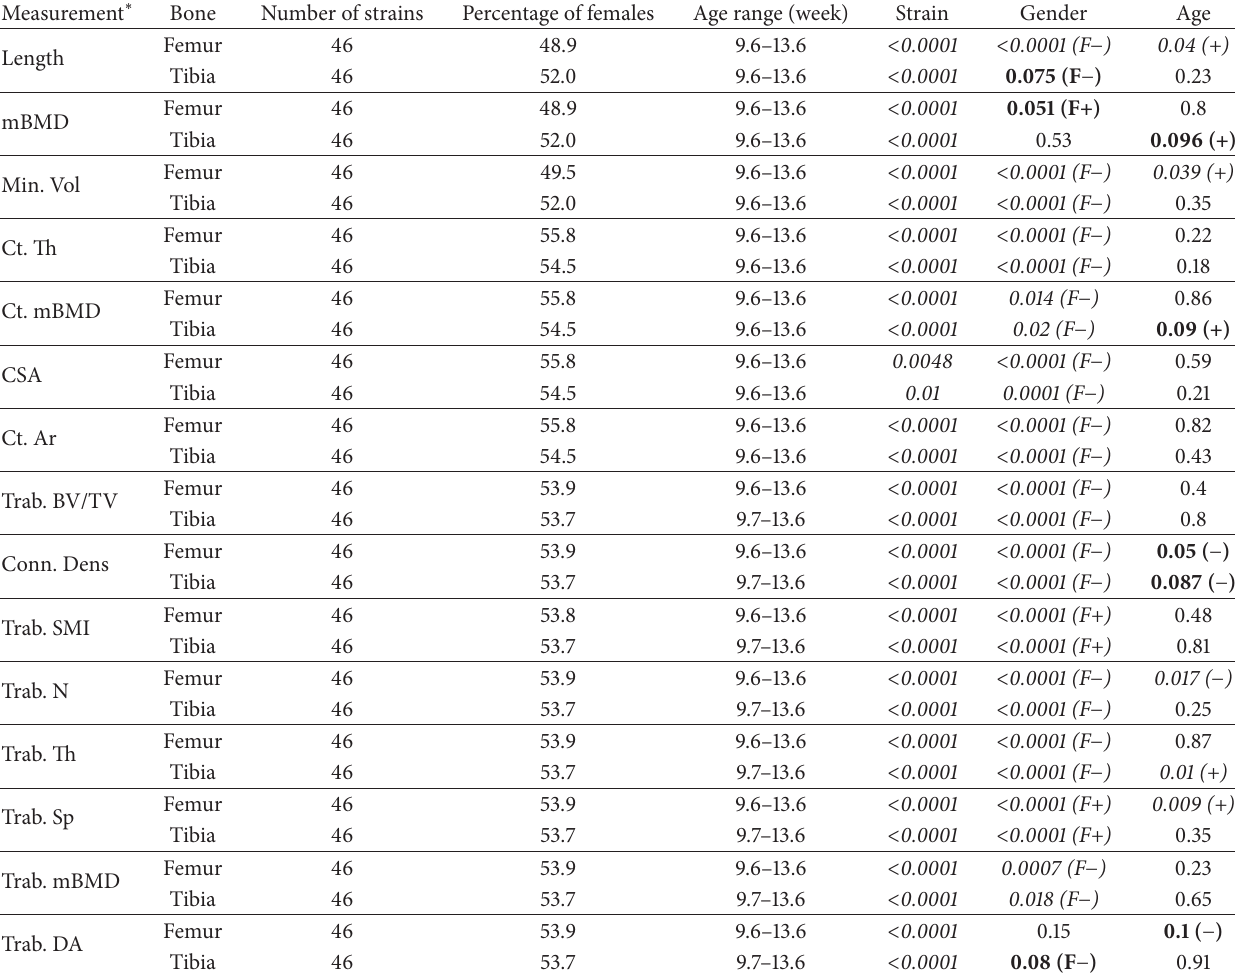
Table 1: 𝑃 value of strain effect on bone morphological and biomechanical properties in femur and tibia of RI mice adjusted for gender and age ( 𝑁 > 3